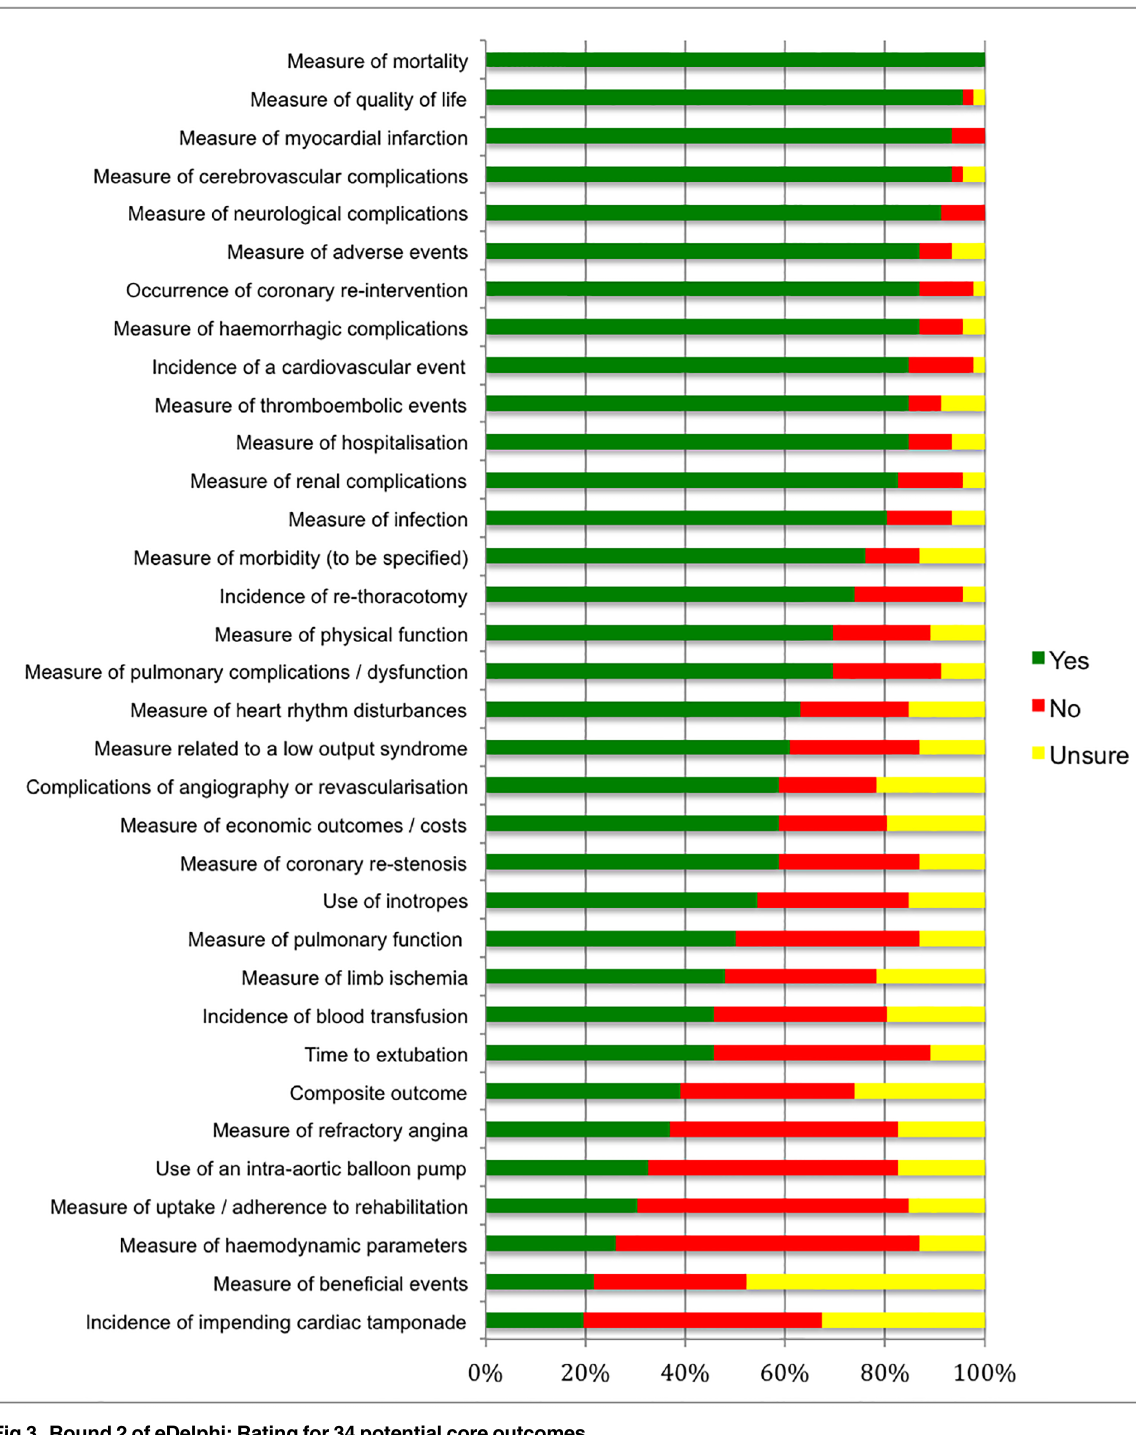
PLOS ONE | https://doi.org/10.1371/journal.pone.0186772 November2,